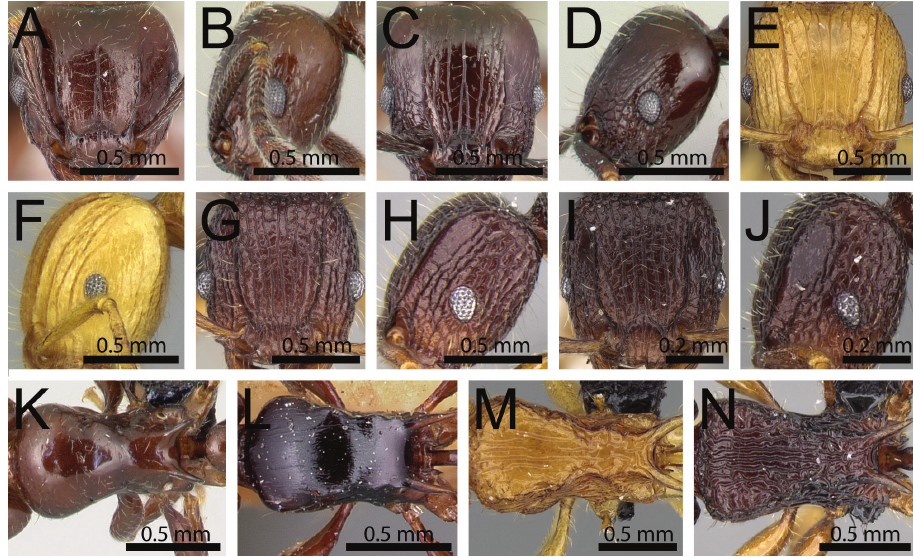
Figure 18. Head (without mandibles) in dorsal and lateral view; Mesosoma in dorsal view. A, B T. ryanphelanae (CASENT0454495) C, D T. silvicola (CASENT0042828) E, F, M T. elf (CASENT0045788) G, H, N T. jedi (CASENT0043578) I, J T. quasirum (CASENT0280585) K T.